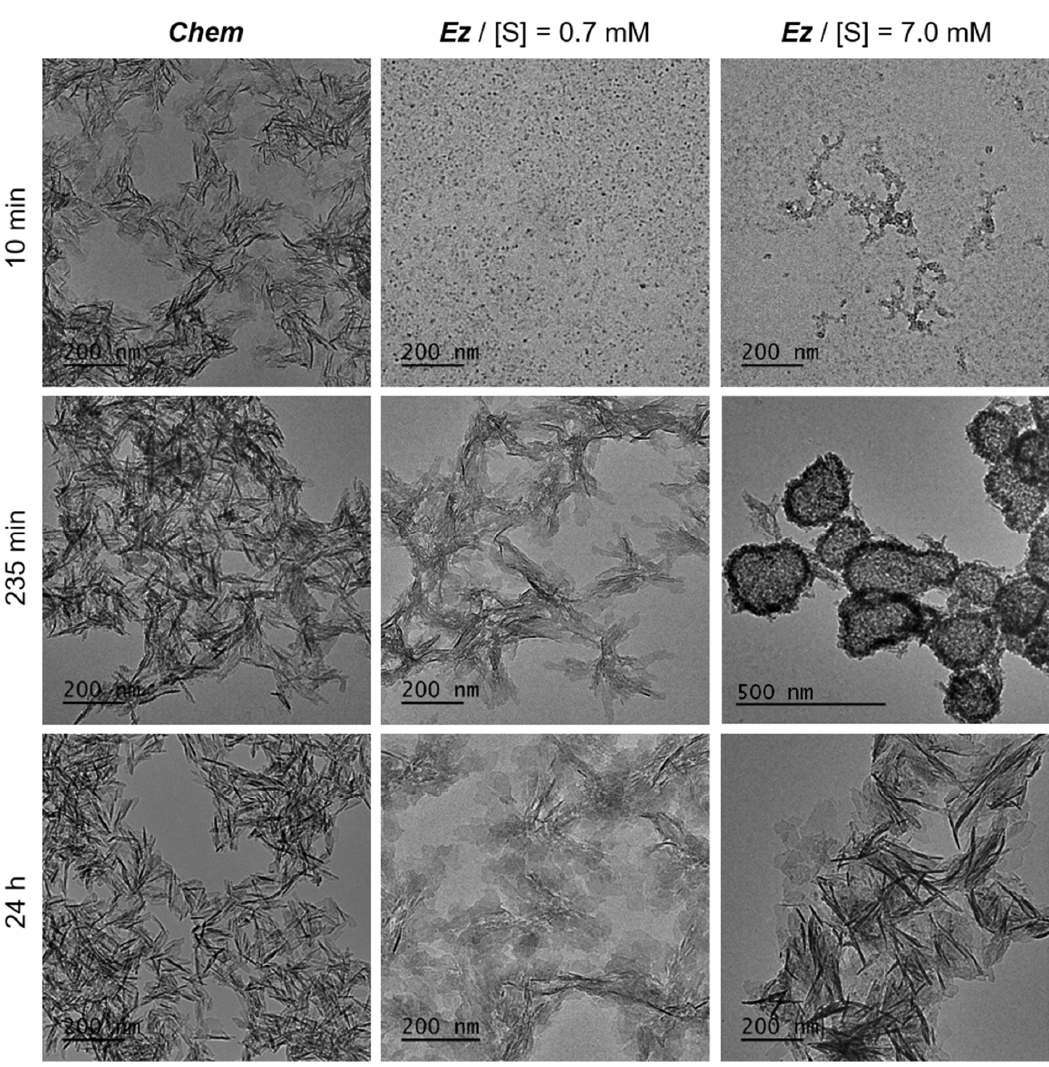
Figure 5. Enzyme-assisted mineralization in homogeneous phase. TEM micrographs for different conditions of mineralization in solution, with [Ca 2+ ] = 11.4 mM initially at pH = 7.4 and 37 °C: (left column): without enzyme; (middle column): with ALP enzyme and 0.7 mM of substrate, α-glycerol phosphate magnesium salt (S); (right column): with ALP enzyme and [S] = 7.0 mM. (Top row): minerals obtained after 10 min, (middle row): after 235 min, (bottom row): after 24 h. For [S] = 7.0 mM, after 235 min, DCPD particles, not shown here, were also formed. Adapted from [124].